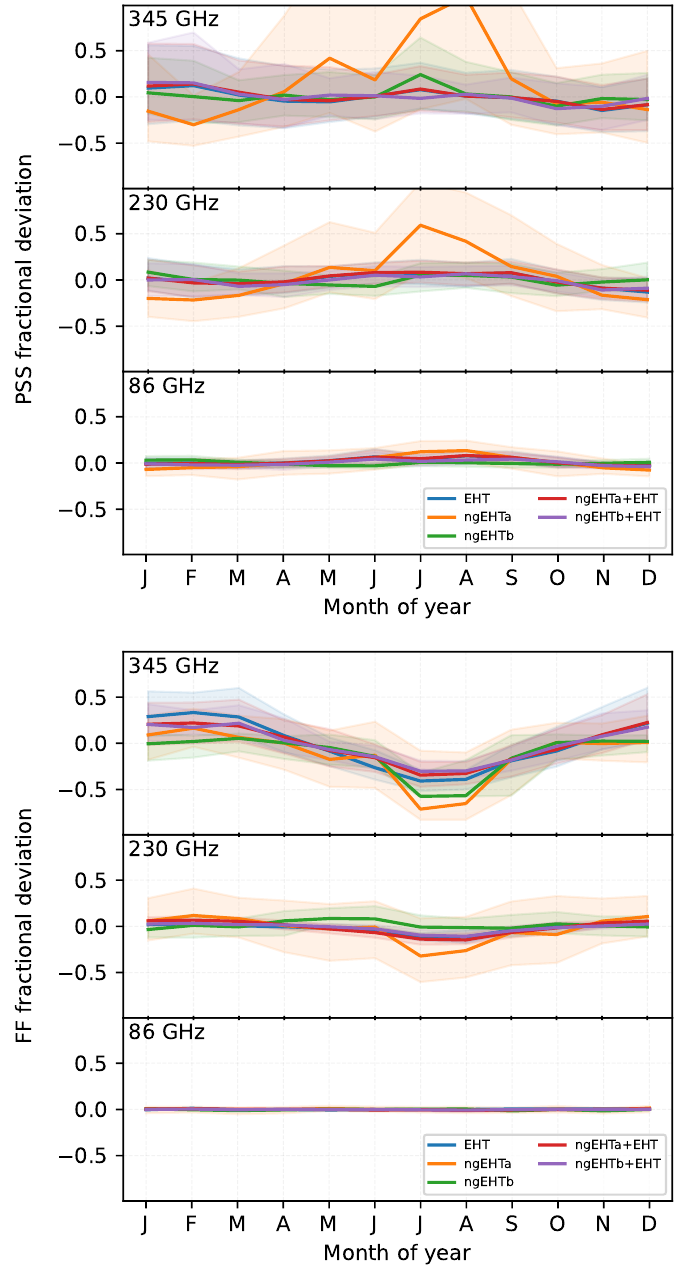
Figure 6. Deviation of the PSS ( top panel ) and FF ( bottom panel ) metrics from their yearly median values, each plotted as a fraction of that median value versus time for five different array configura- tions. The EHT, ngEHTa, ngEHTb, ngEHTa+EHT, and ngEHTb+EHT arrays are each plotted in a different color, as indicated in the legend. The top, middle, and bottom rows in each panel correspond to observing frequencies of 345, 230, and 86GHz, respectively. The light shaded region around each line encompasses the inter-quartile range determined by the weather Monte Carlo procedure. A target field-of-view of 1000 µ as has been assumed for all ( u , v ) -filling fraction